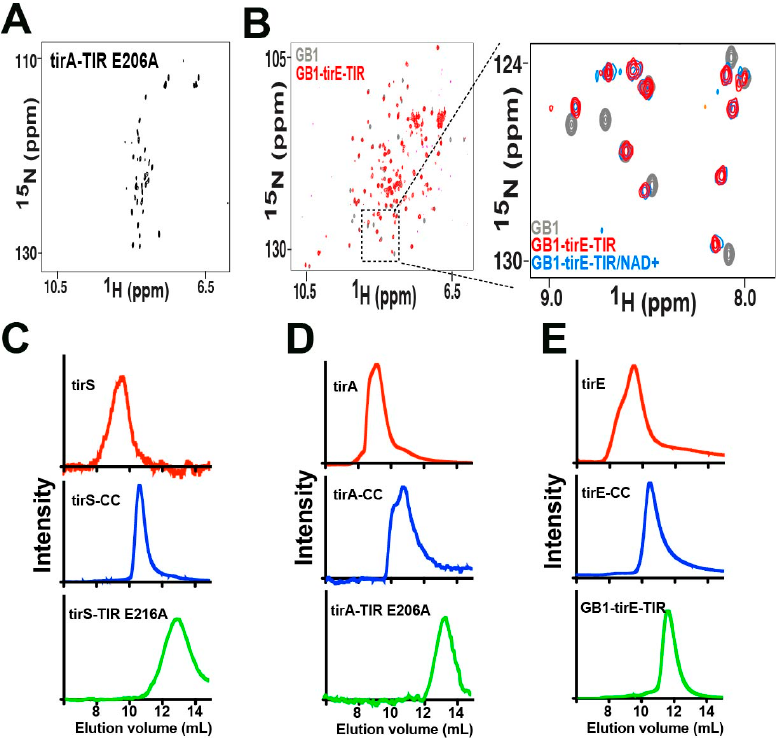
Figure 3. Biophysical and biochemical analysis of bacterial TIR-containing proteins. ( A ) The 15 N- HSQC spectra of the tirA-TIR E206A mutant. ( B ) The 15 N-HSQC spectra of GB1 alone (gray) and GB1-tirE-TIR (red) with an enlargement including the additional spectrum of GB1-tirE-TIR incubated with saturating concentrations of NAD + (blue). ( C ) Analytical sizing of full-length tirS (red), tirS-CC (blue), and the tirS-TIR E216A mutant (green). ( D ) Analytical sizing of full-length tirA (red), tirA-CC (blue), and the tirA-TIR E206A mutant (green). ( E ) Analytical sizing of full-length tirE (red), tirE-CC (blue) and GB1-tirE-TIR (green). Sample loads were all 100 mL of 200 μ M, except tirS-TIR E216A and tirS-TIR E206A, which were 20 μ M and 50 μ M, respectively.